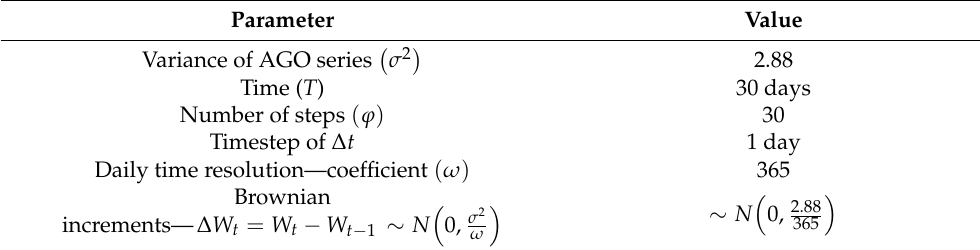
0.01.02.03.04.05.06.0 Figure 9. Accumulated Generation Operation for transformed stationary series (fitting period). The following matrices are used to calculate parameters a and b of the grey modeling: B = Table 12. Parameters of stochastic AGO series of transformed stationary series.